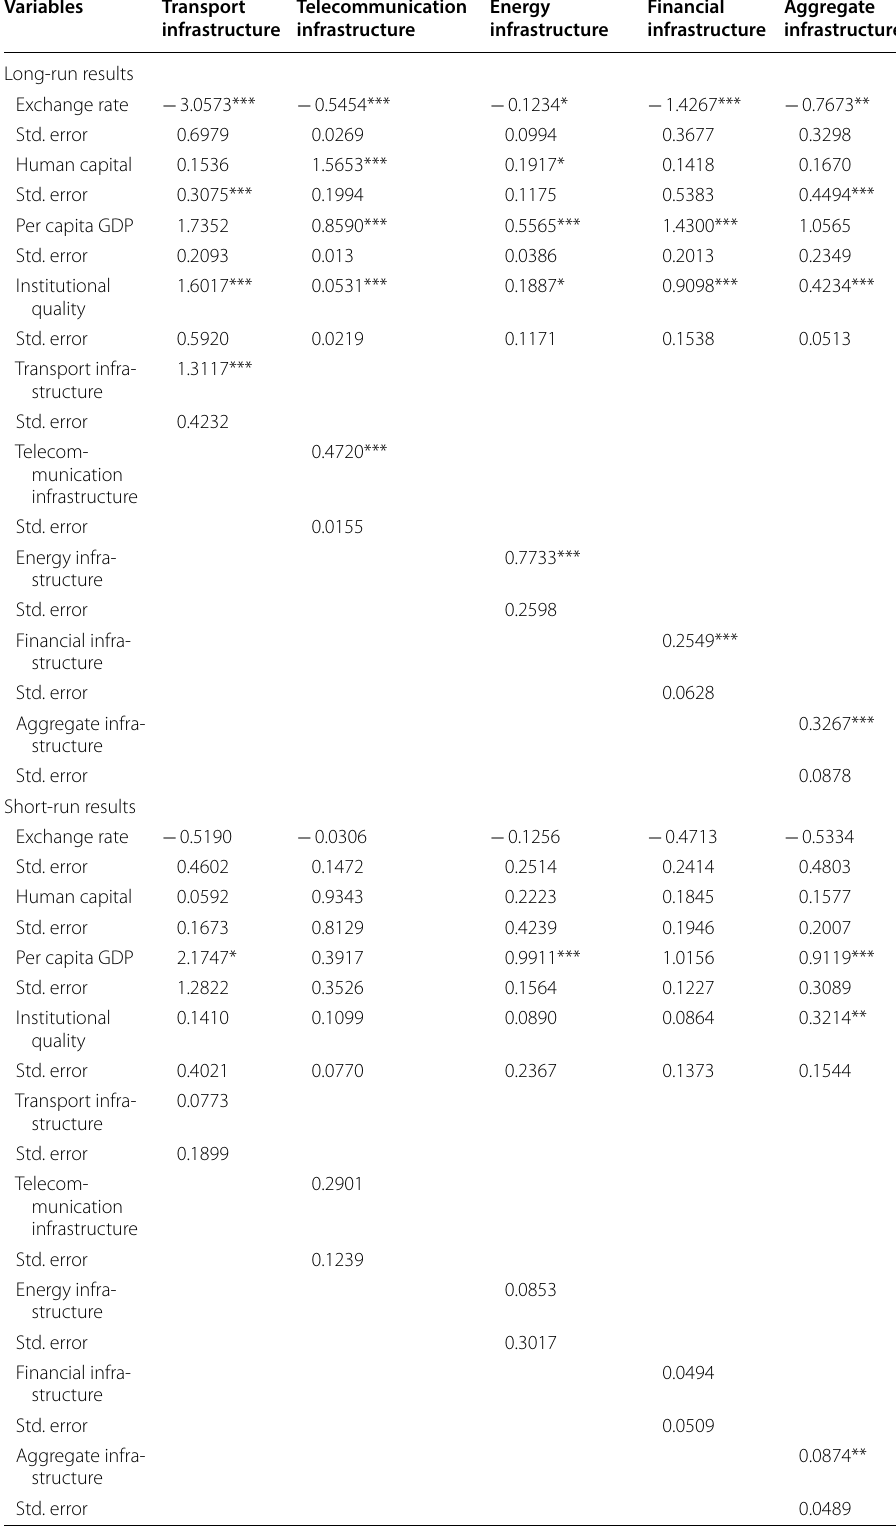
Table 3 Pooled Mean Group method results (export is dependent variable)